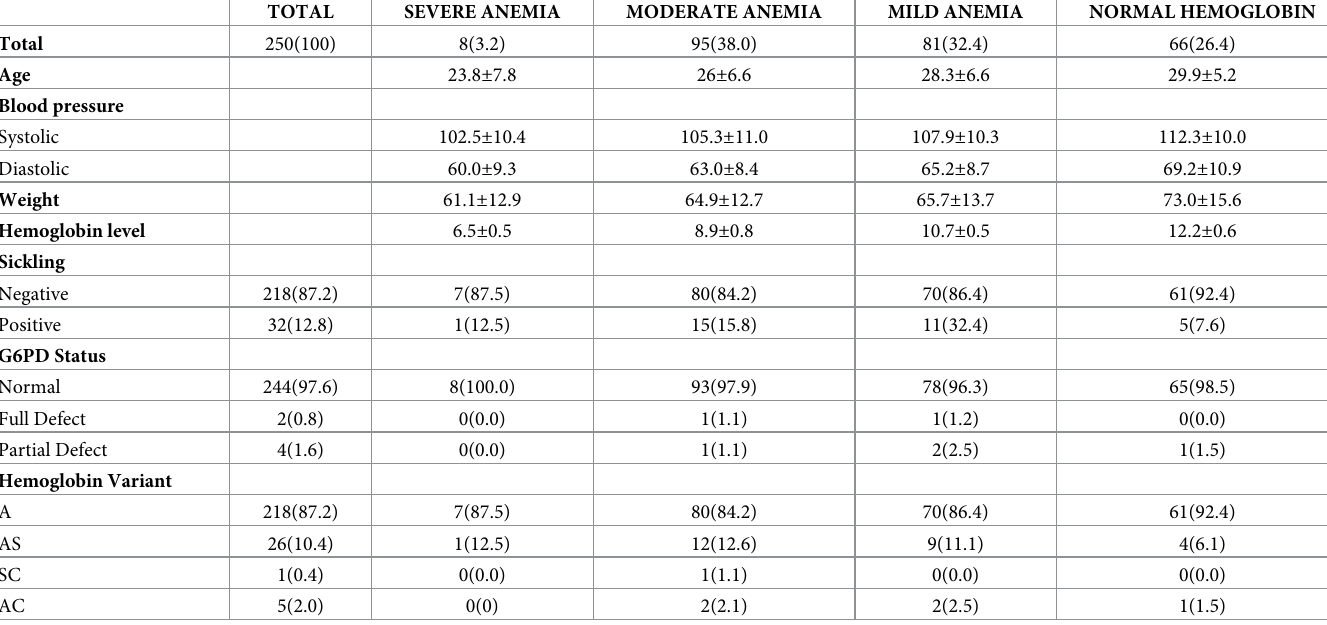
Table 3. Demographic characteristics and laboratory presentation of the pregnant women stratified into severe anemia (Hb < 7.0g/dl), moderate anemia (Hb = 7.0– 9.9g.dl), mild anemia (Hb = 10.0–11.4g/dl) and normal hemoglobin (Hb > = 11.5g/dl). TOTAL SEVERE ANEMIA MODERATE ANEMIA MILD ANEMIA NORMAL